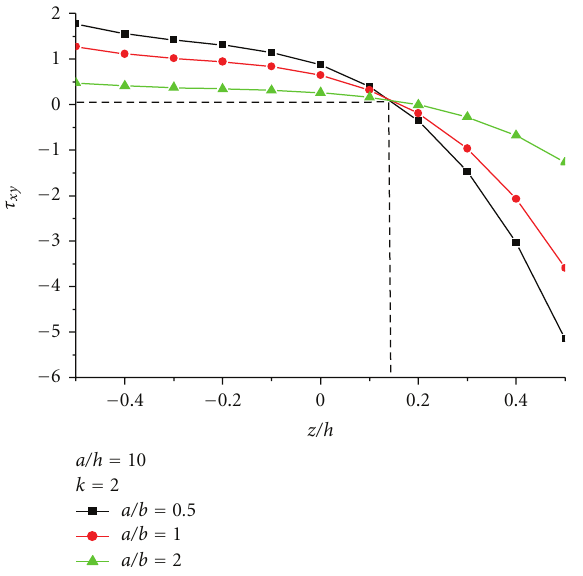
Figure 9: Variation of transversal shear stress ( τ xz ) through the thickness of an FGM plate for di ff erent values of the aspect